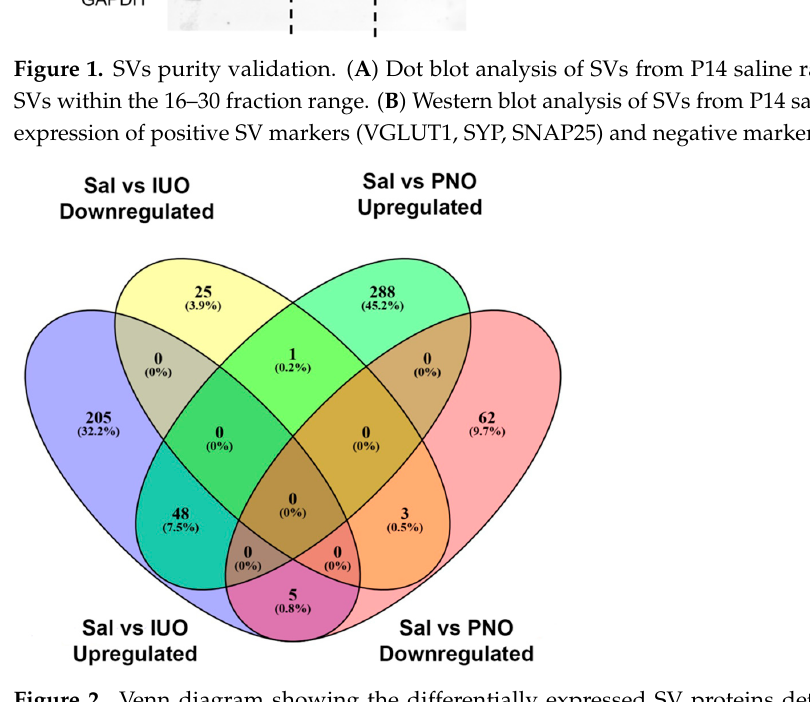
Figure 2. Venn diagram showing the differentially expressed SV proteins determined from the proteomics screen.